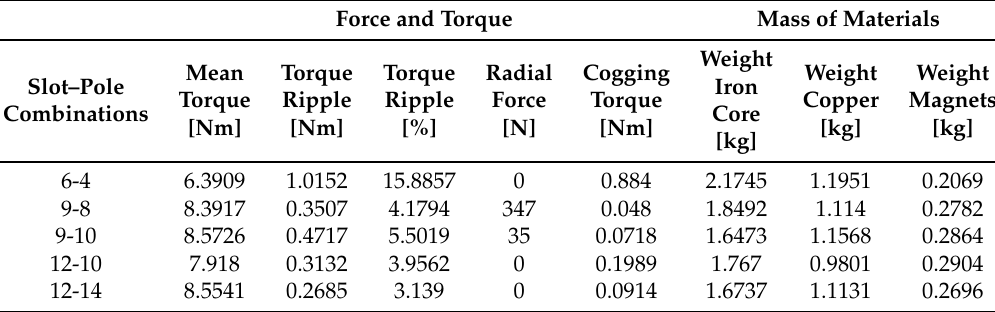
Table 6. Performance of healthy DL slot–pole combinations, Part I.